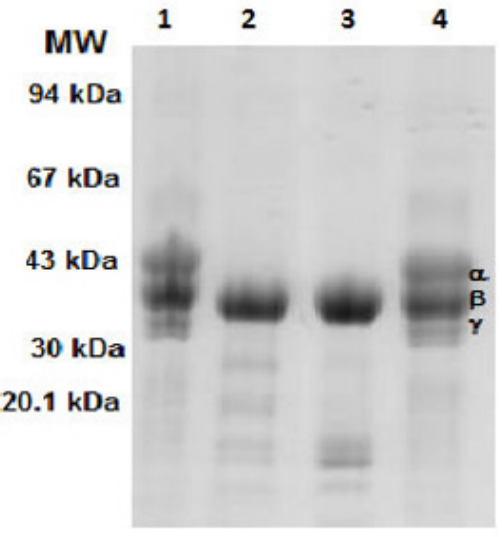
Figure 5. Fibrinogen degradation profile. Lane 1: Naja haje venom; lane 2: Cerastes cerastes venom; lane 3: Macrovipera mauritanica venom; and lane 4: fibrinogen.